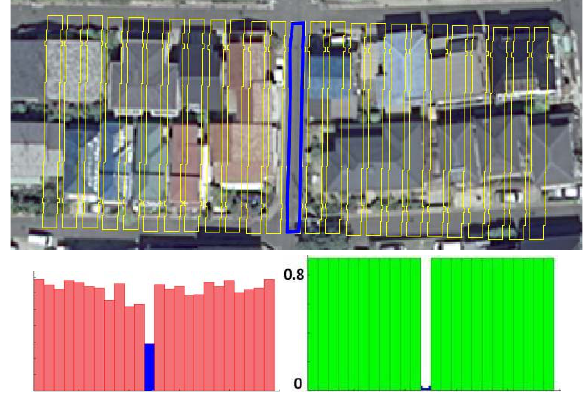
Figure 3: Input image with road region (blue) and 24 non-road regions (yellow). Left: the computed SSH scores over the profile index. Right: and an optimal SSH configuration.